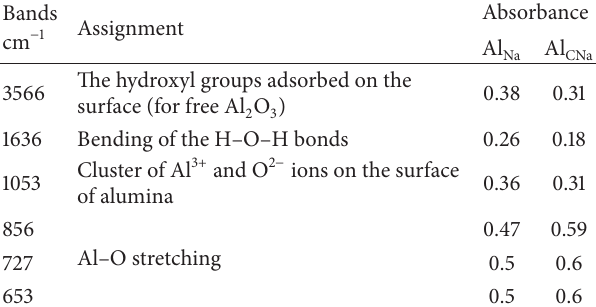
Table 5: DRIFT bands that are characterizing coated and